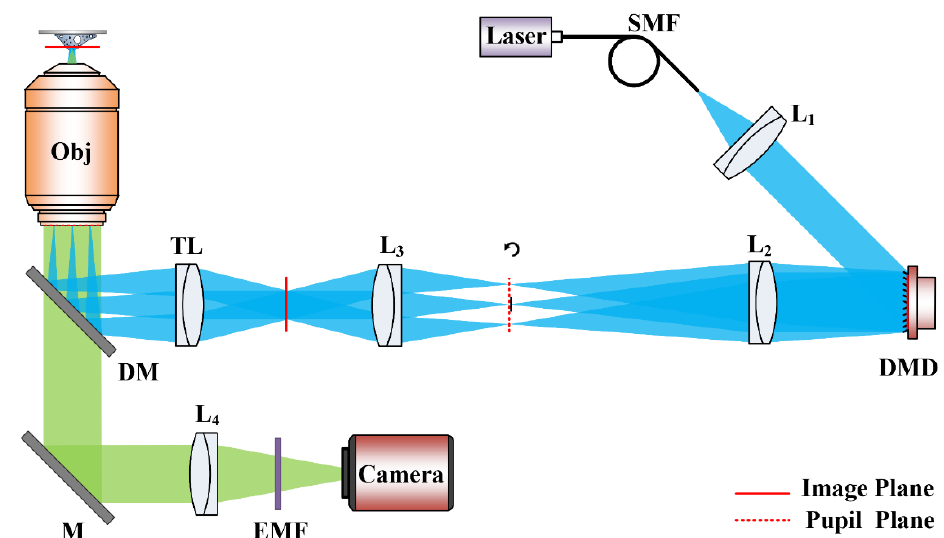
Figure 2. Schematic diagram of a fast structured illumination microscopy system setup. SMF: single-mode fiber; L: lens; TL: tube lens; DM: dichroic mirror; OBJ: objective; M: mirror; EMF: emission filter.